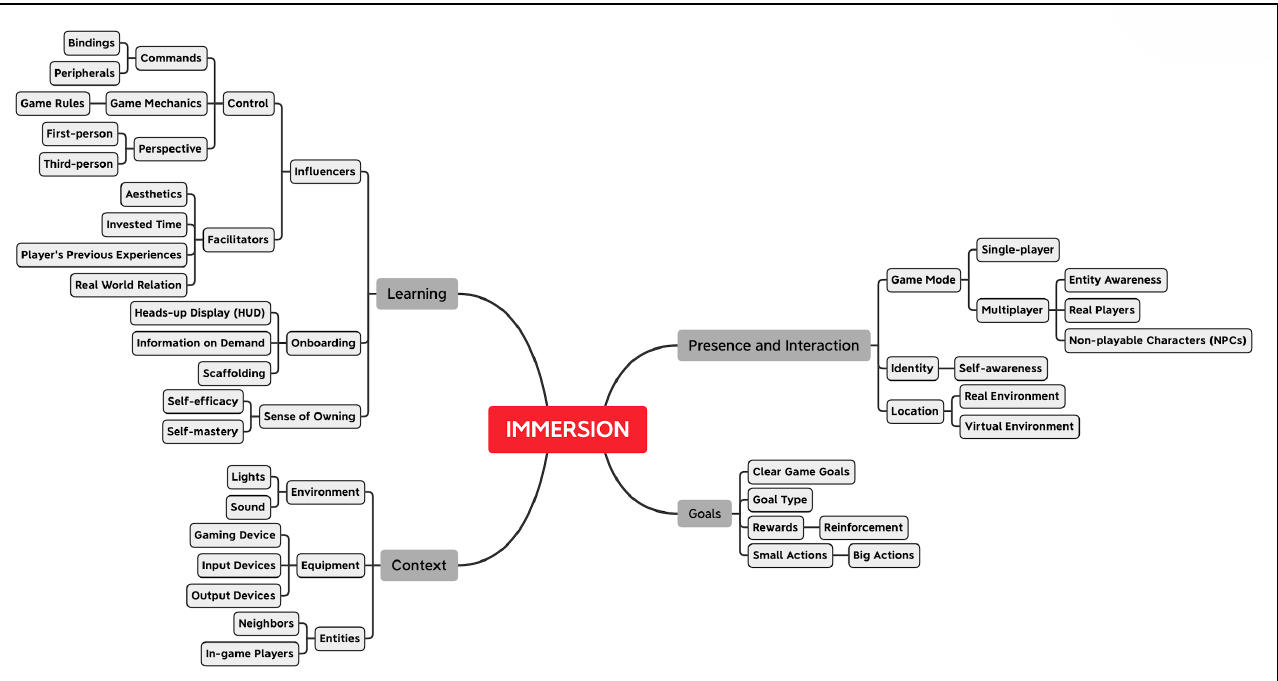
Figure 5. The GLIMPSE